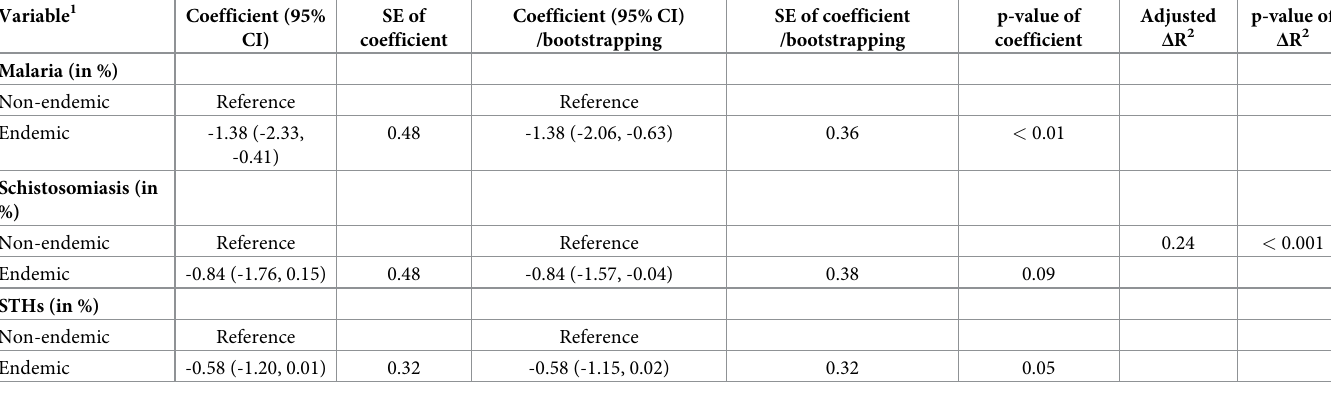
Table 4. Summary of associations between parasitic disease variables and root-transformed COVID-19 incidence rates.